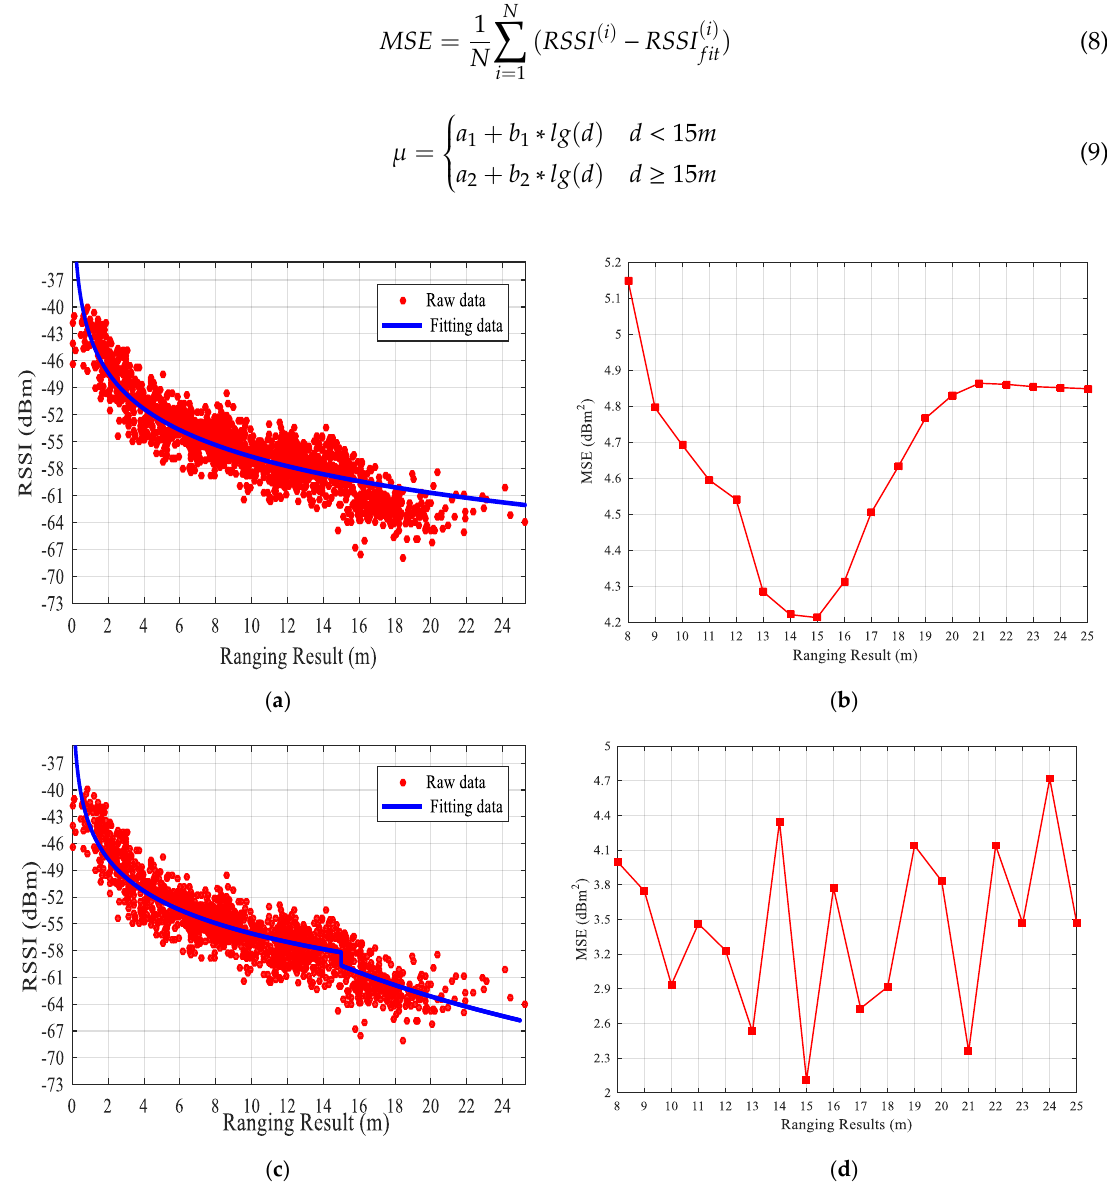
Figure 7. Experimental results of the fitting. ( a ) Comparison of the fitting data using the single exponential model and the raw RSSI data. ( b ) Mean square error (MSE) of the fitting, from 0 m to different distances, using the single exponential model. ( c ) Comparison of the fitting of data using the double exponential model and the raw RSSI data. ( d ) MSE of the fitting, from 0 m to different distances, using the single exponential model.